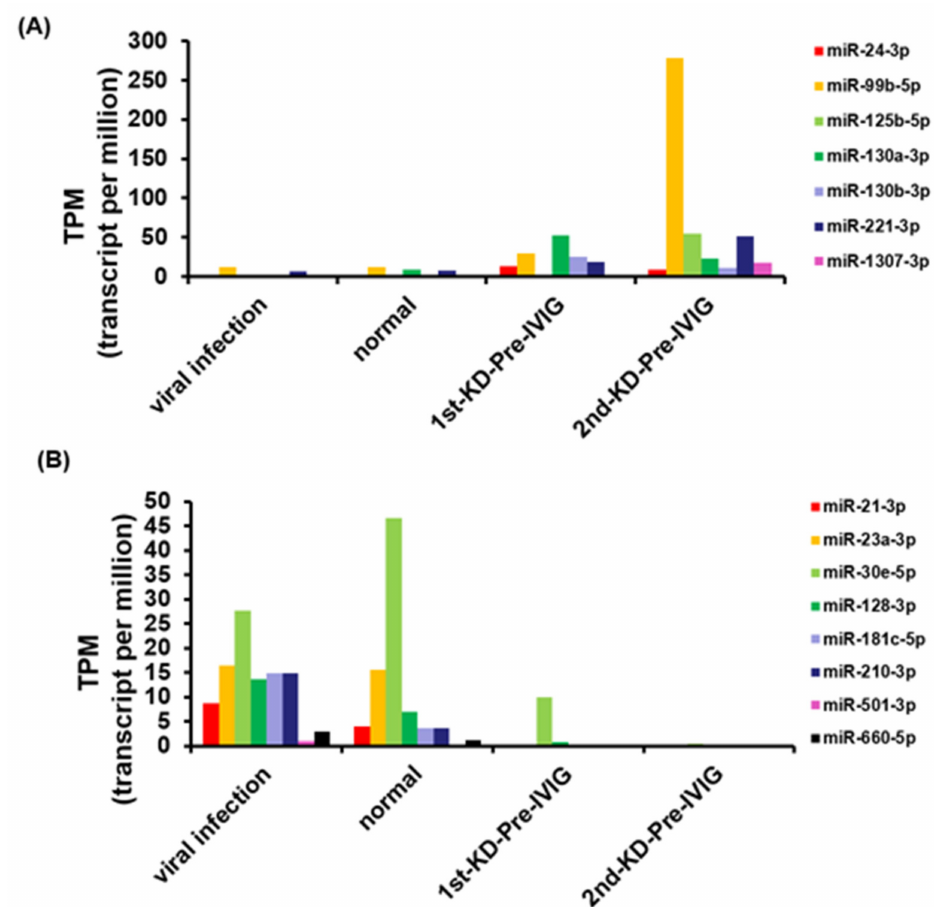
Figure 2. Expression levels of 15 miRNA candidates, obtained by analyzing NGS data. ( A ) The expression levels of seven circulating miRNAs were higher in the recurrent KD group than in the healthy and viral infection control groups. ( B ) The expression levels of eight circulating miRNAs were decreased in the recurrent KD group compared with the healthy and viral infection control